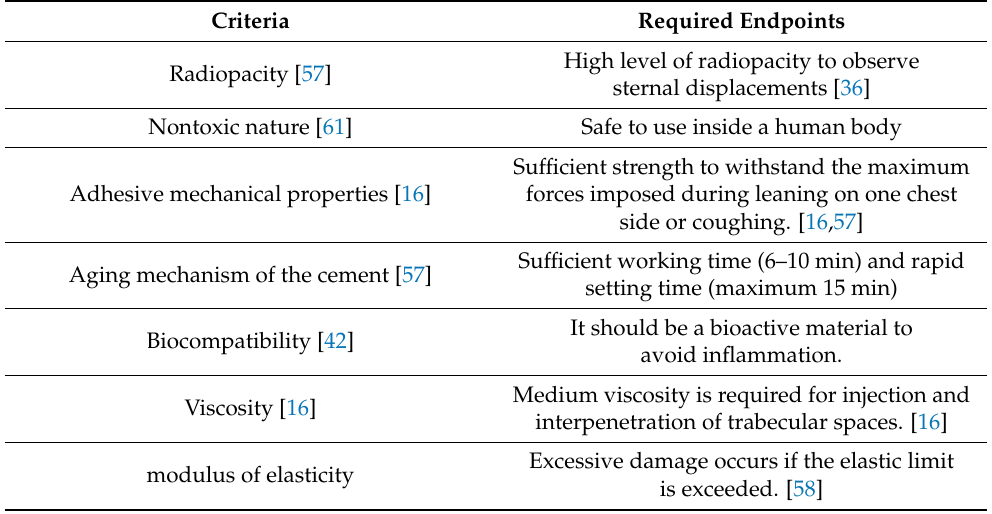
Table 2. Requirements for cements used in orthopedic medical